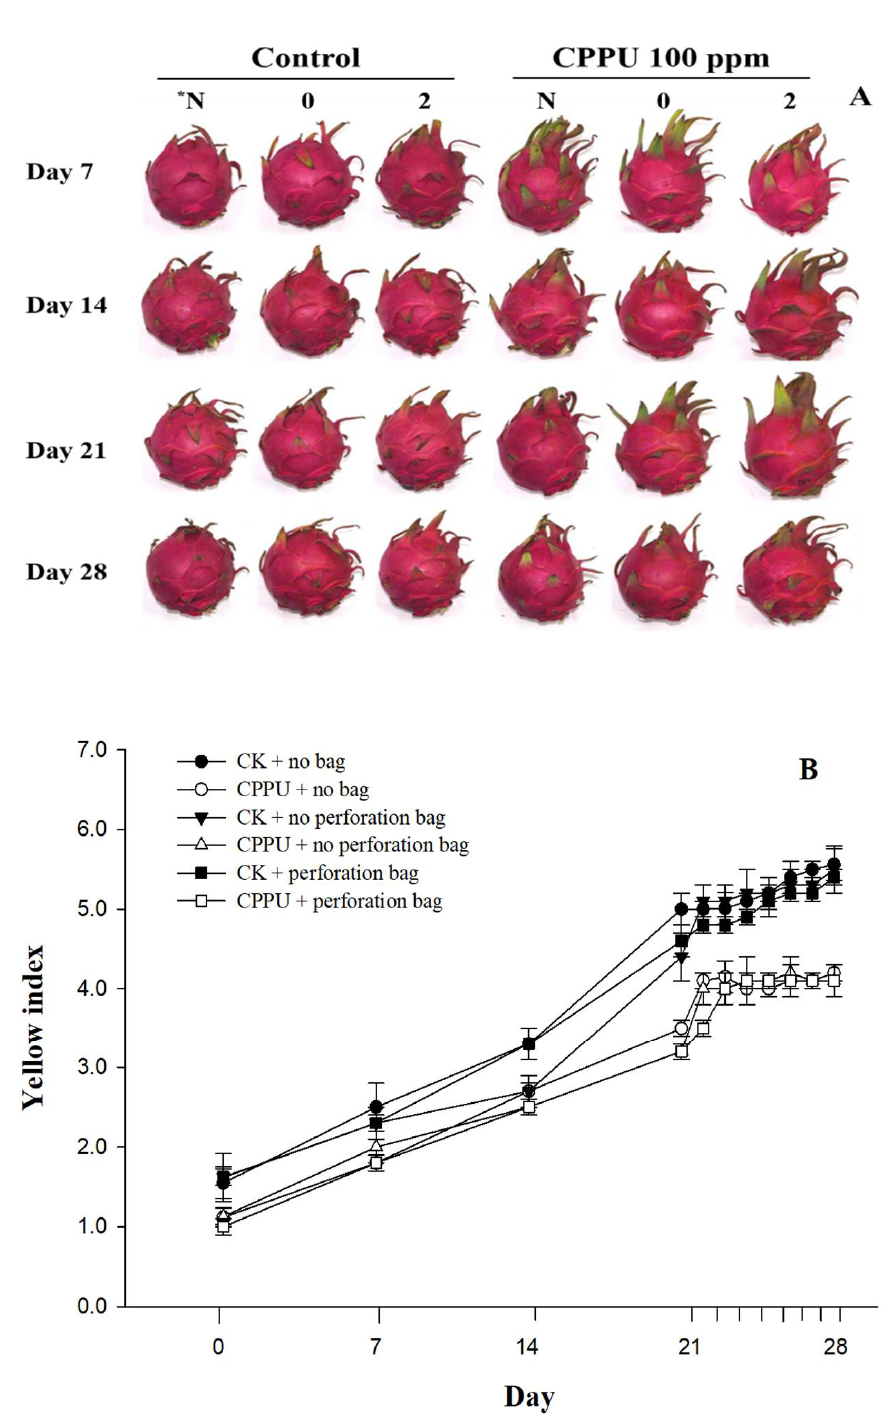
Figure 2. The effect of preharvest application of CPPU and perforation packaging on bract browning of ‘Da Hong’ ( A ) and yellow index ( B ) during postharvest storage at 5 ◦ C, and transferred to 20 ◦ C for 7 days. Bars represent means of four replications ± SD ( n = 4). *N: Fruit without packaging; 0: Fruit packed without perforation; 2: Fruit packed with perforation.